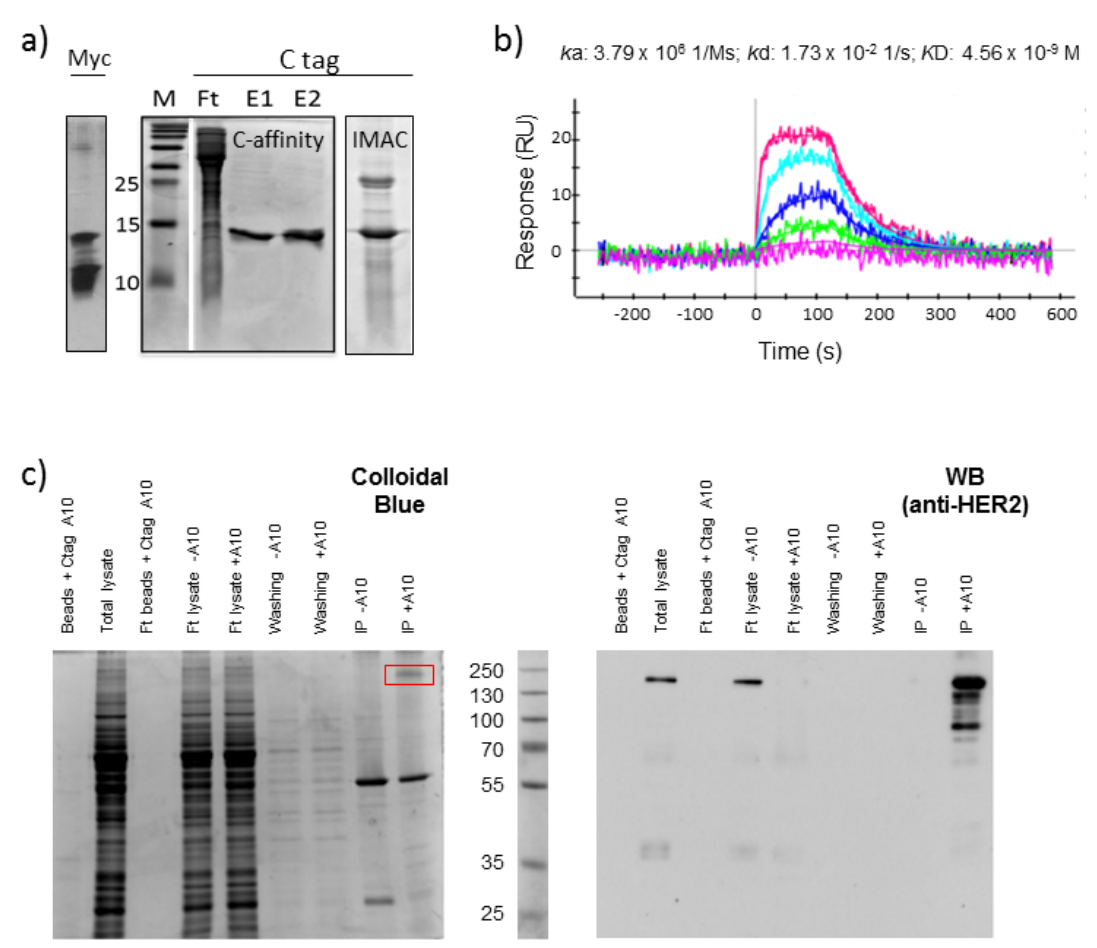
Figure 1. Purification and functional validation of the single-domain antibody fused to C tag. ( a ) The single-domain antibody A10 expressed by the phagemid pHEN2 was purified by IMAC as a VHH-His-myc construct (Myc). The same antibody was also expressed as VHH-His-C tag and purified either by immune-affinity using an anti-C tag antibody or by IMAC (C tag). The immune- purified (E1 and E2) and IMAC elution fractions were separated by SDS-PAGE, compared with the flow-through (Ft) and the marker (M), and stained with colloidal blue. ( b ) The affinity of the VHH-His-C tag construct was assessed by surface plasmon resonance (SPR) in combination with the recombinant HER2 ectodomain ( c ) The same construct was used to precipitate HER2 from SKBR3 cell lysate. The control and experimental fractions used for immunoprecipitation were separated in parallel and either stained with colloidal blue or used for western blot in combination with a commercial